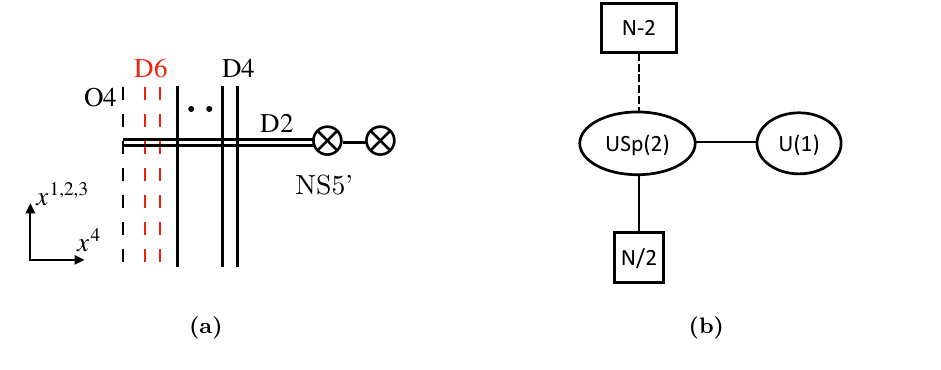
Figure 15. (a): the brane configuration for the monopole screening contribution to the v = 0 sector in T V · T V . (b): the corresponding quiver